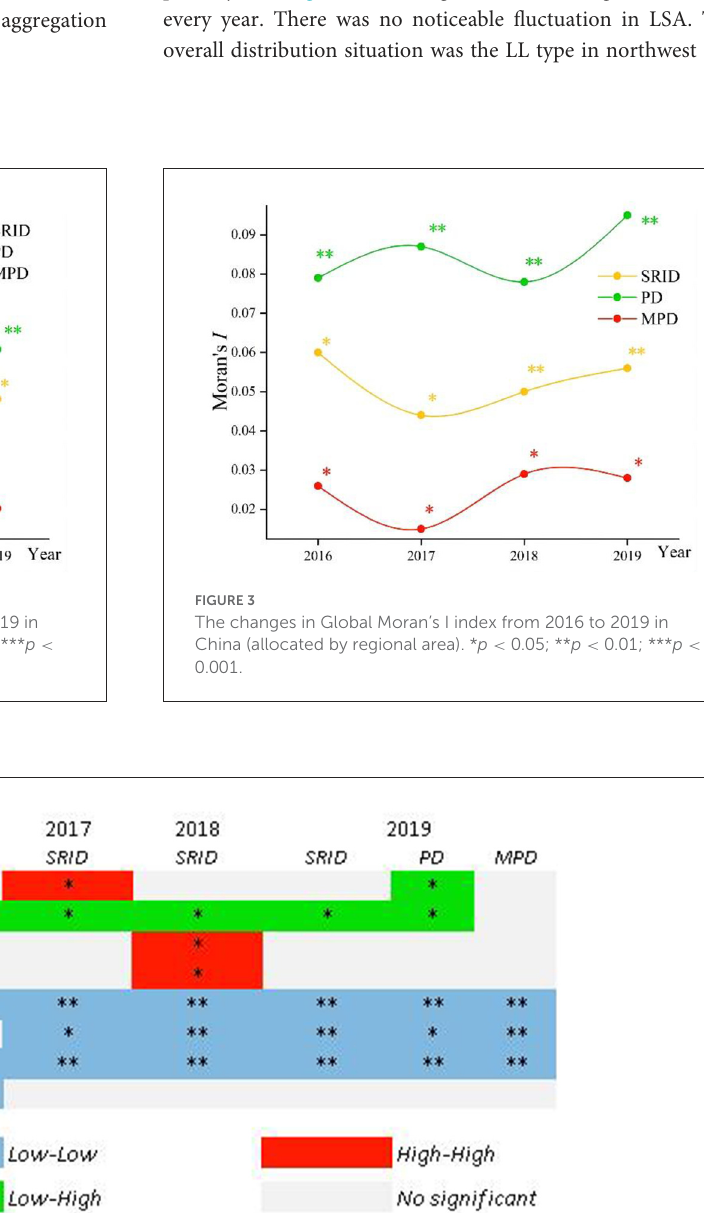
FIGURE4 LISA maps for SRID from 2016 to 2019; PD and MPD in 2019. * p < 0.05; ** p < 0.01; *** p < 0.001. Z-score test, 999 randomized replacement. Other provinces not shown means that all the test indicators were not significant.